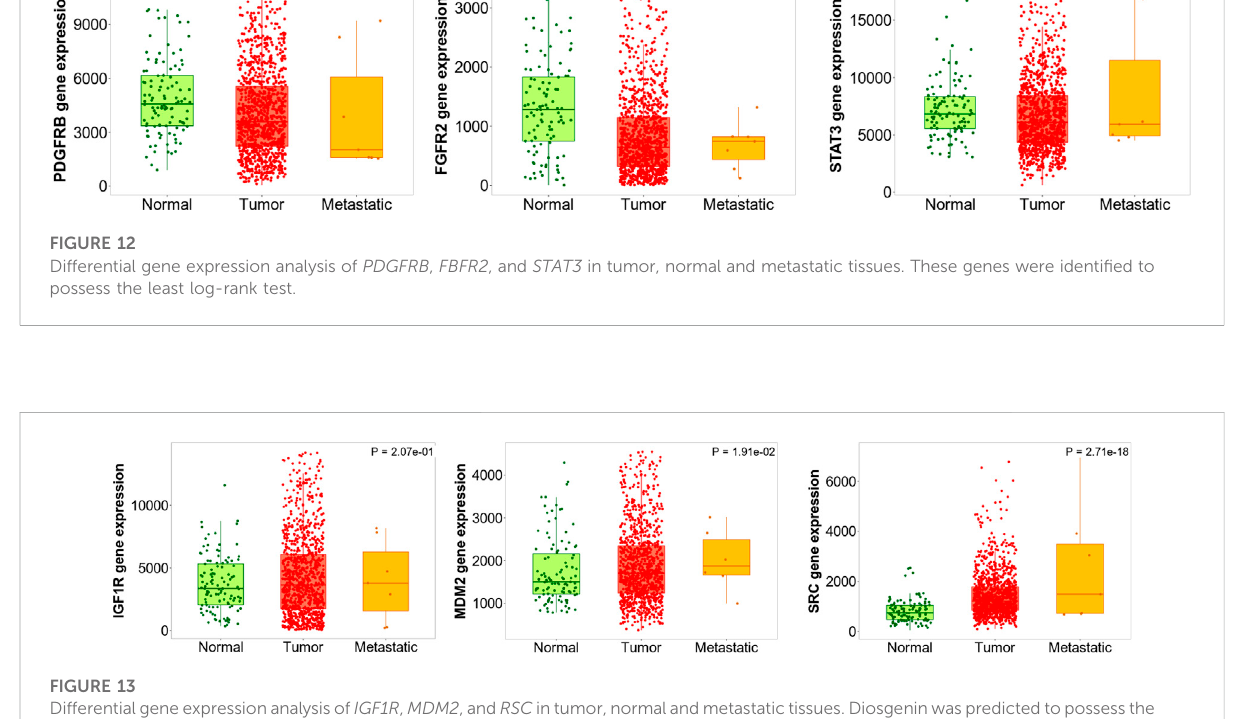
Table S5). The concentration-dependent effect of diosgenin and